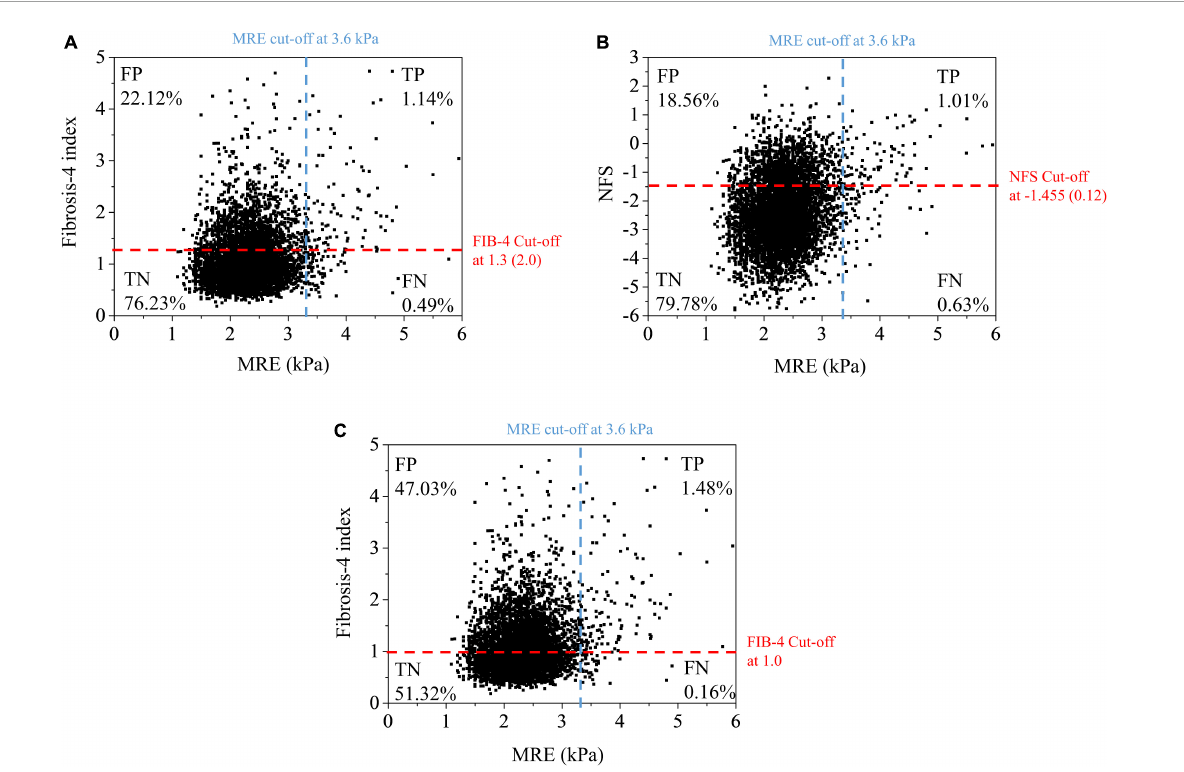
FIGURE3 Scatter plot of liver stiffness measured by MRE vs. fibrosis-4 index (A,C) at different cut-off values and NFS (B) . Pearson correlation coefficient: MRE – FIB-4 (0.232), MRE – NFS (0.192). FN, false negative; FP, false positive; MRE, magnetic resonance elastography; NFS, NAFLD fibrosis score; FIB-4, fibrosis-4 index; TN, true negative; TP, true